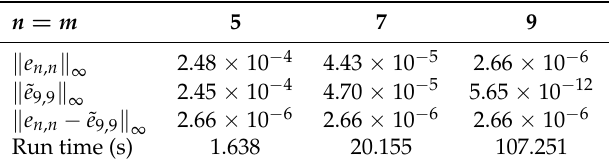
Table 6. The norms of absolute errors, the estimation of the errors by using the residual correction procedure, and the errors obtained by the corrected approximate solutions of Example 3 for s = p = 9.